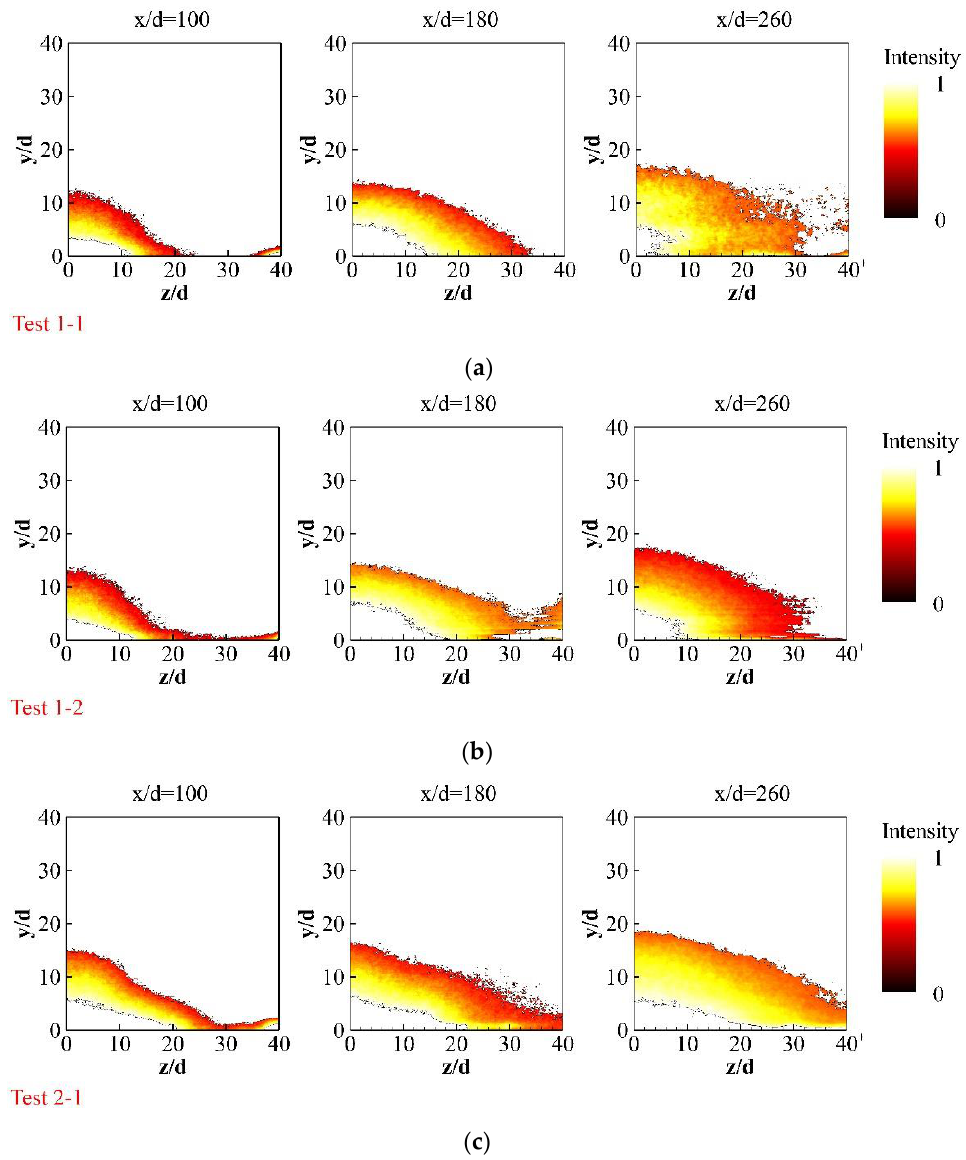
Figure 11. Cross-sectional plume structures of EHF jet injected into Ma 2.0 crossflow. ( a ) Ma = 2.0, P j = 2.8 MPa, T j = 705 K. ( b ) Ma = 2.0, P j = 2.8 MPa, T j = 730 K. ( c ) Ma = 2.0, P j = 4.2 MPa, T j = 707 K.